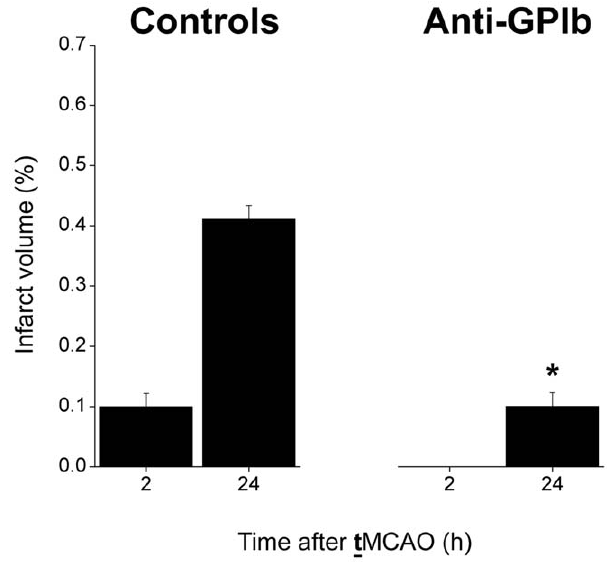
Figure 4. Whole-brain volumetric analysis of cerebral infarc- tion. The whole-brain segmentation of cerebral infarction was accomplished by visual delination on T2-w RARE images. The infarct volume is given as percentage of the whole-brain volume. Control mice after t MCAO (left) showed extended cerebral infarctions in the MCA territory at 24 h, preceded by smaller subcortical infarctions at 2 h. In contrast, anti-GPIb treated mice exhibited significantly smaller volumes of completed infarctions ( anti-GPIb vs. controls at 24 h, *p=0.0002). In addition, early after t MCAO at 2 h, cerebral infarction was not detected on visual analysis corresponding to a neglibly small probability of infarction as detected by automated segmentation (see Figs. 3 and 5).